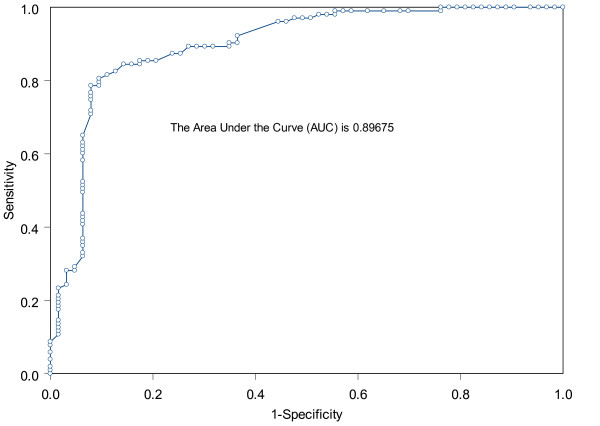
Receiver Operating Characteristic curve drawn using the data on ERα mRNA copy numbers is shown.